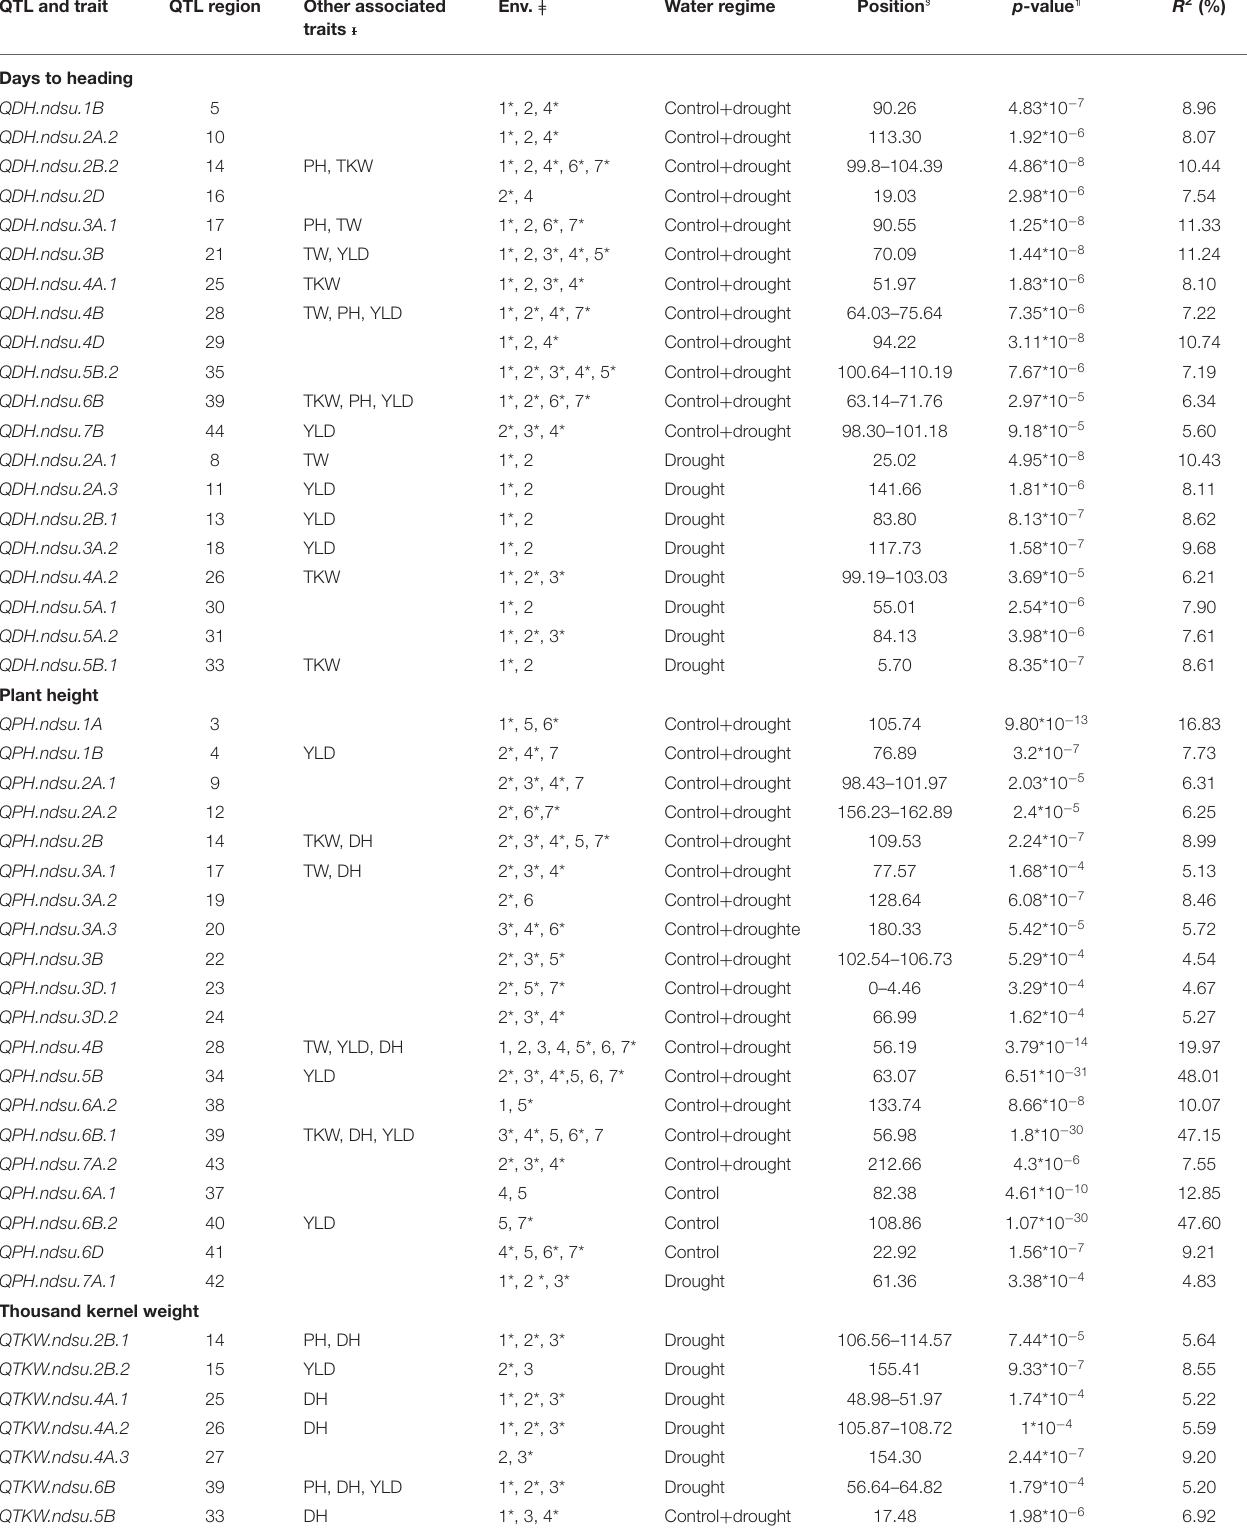
TABLE 4 | Marker-trait associations (QTL) identified for yield and related traits under different environments in this study. QTL and